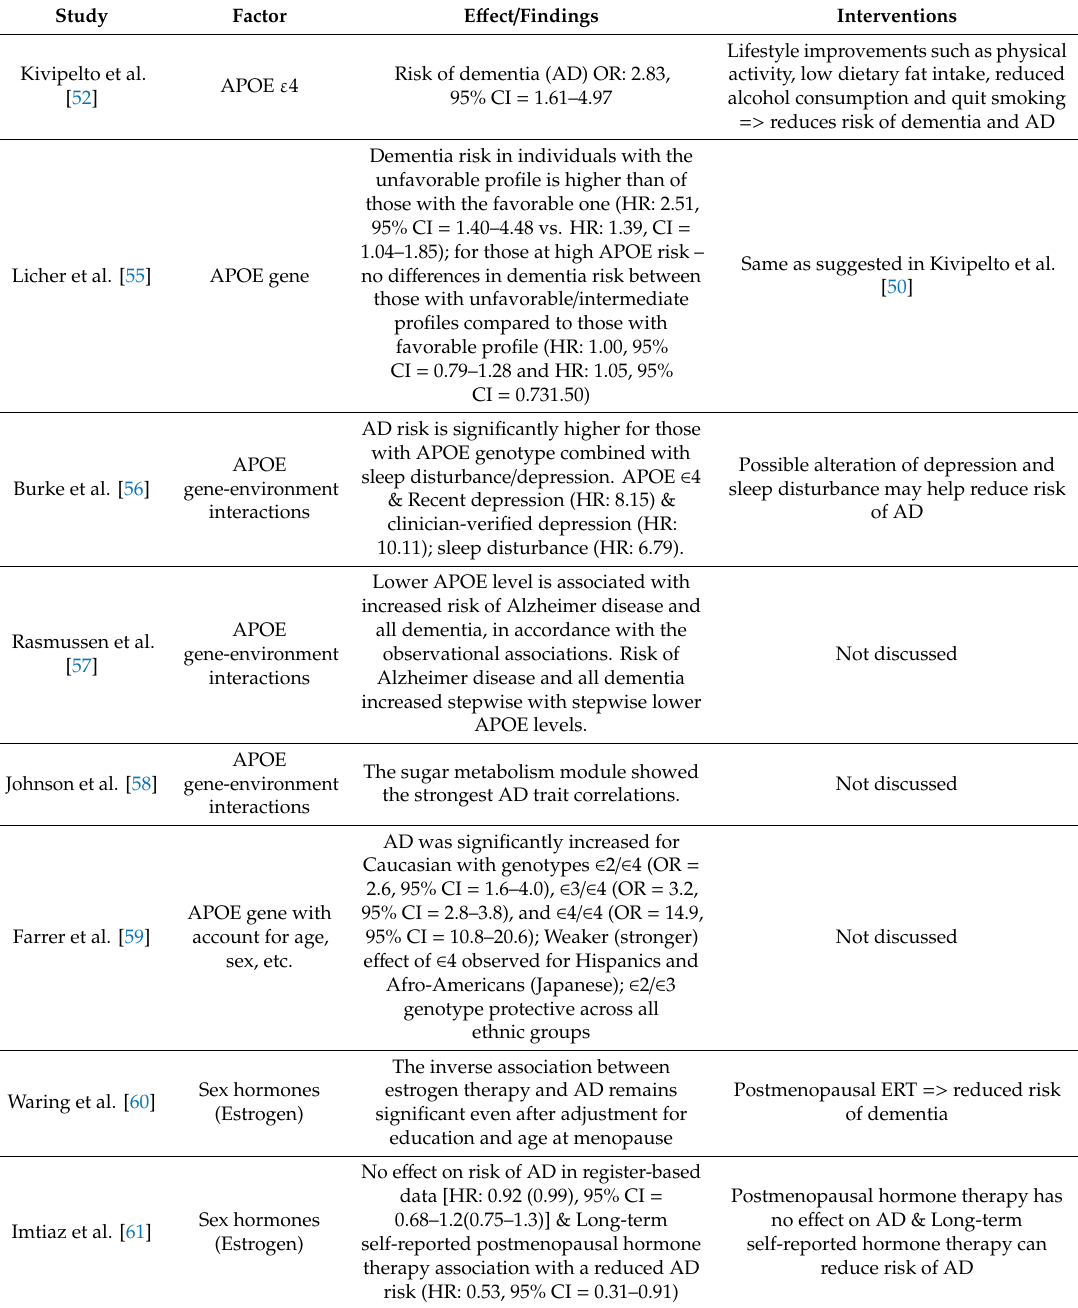
Table 2. E ff ect of the genetic predisposition and changes in sex hormones levels on the risk of dementia /